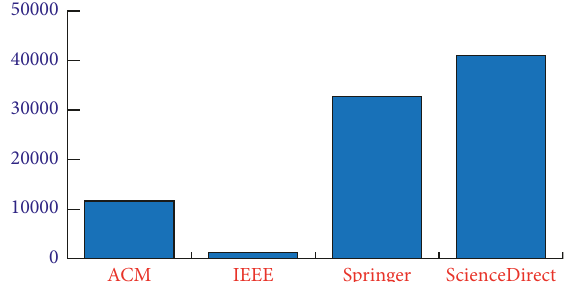
Figure 1: Popularity measurement based on publication of Bloom filter.